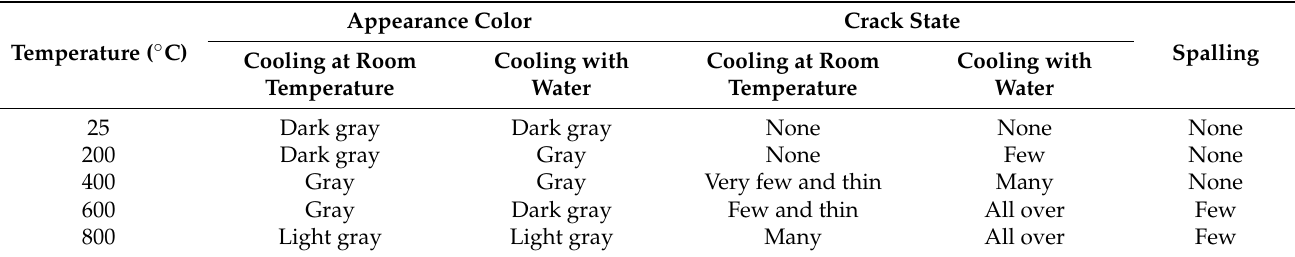
Table 1. Appearance changes of specimens after high-temperature